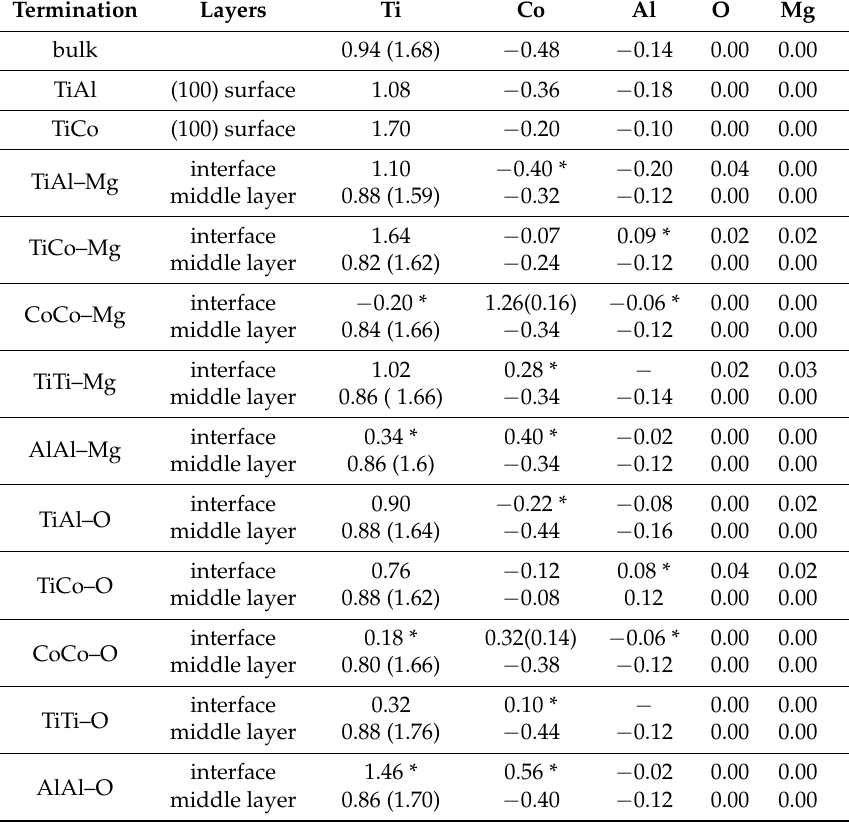
Table 2. Atom-resolved magnetic moments at interface and subinterface layers in Ti 2 CoAl and the interface layer in MgO. The number following “*” denotes the atoms at the subinterface, while the number enclosed in brackets denotes the magnetism coming from different atomic